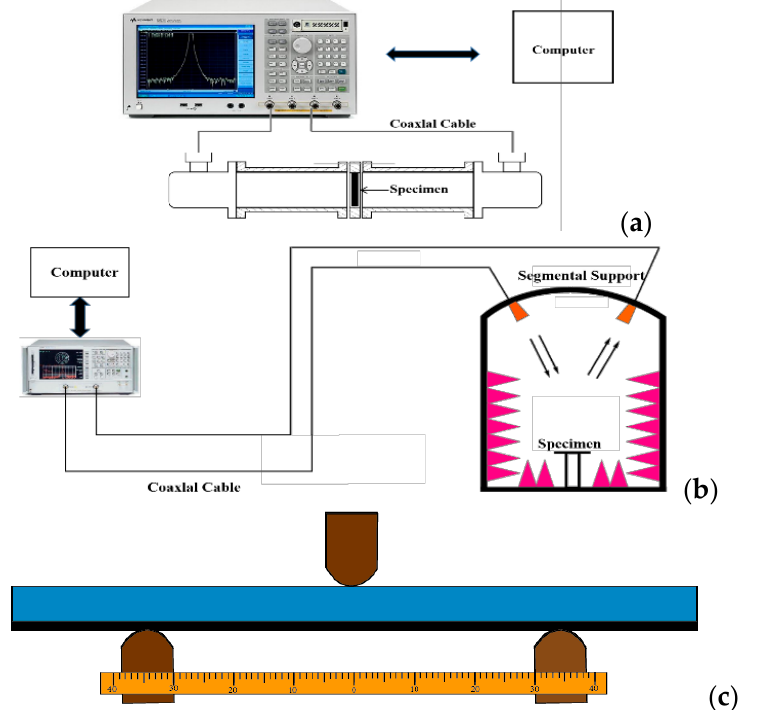
Figure 4. ( a ) Schematic diagram of the dielectric property test equipment; ( b ) schematic diagram of the EM reflection loss test equipment; ( c ) schematic diagram of the three-point bending test.